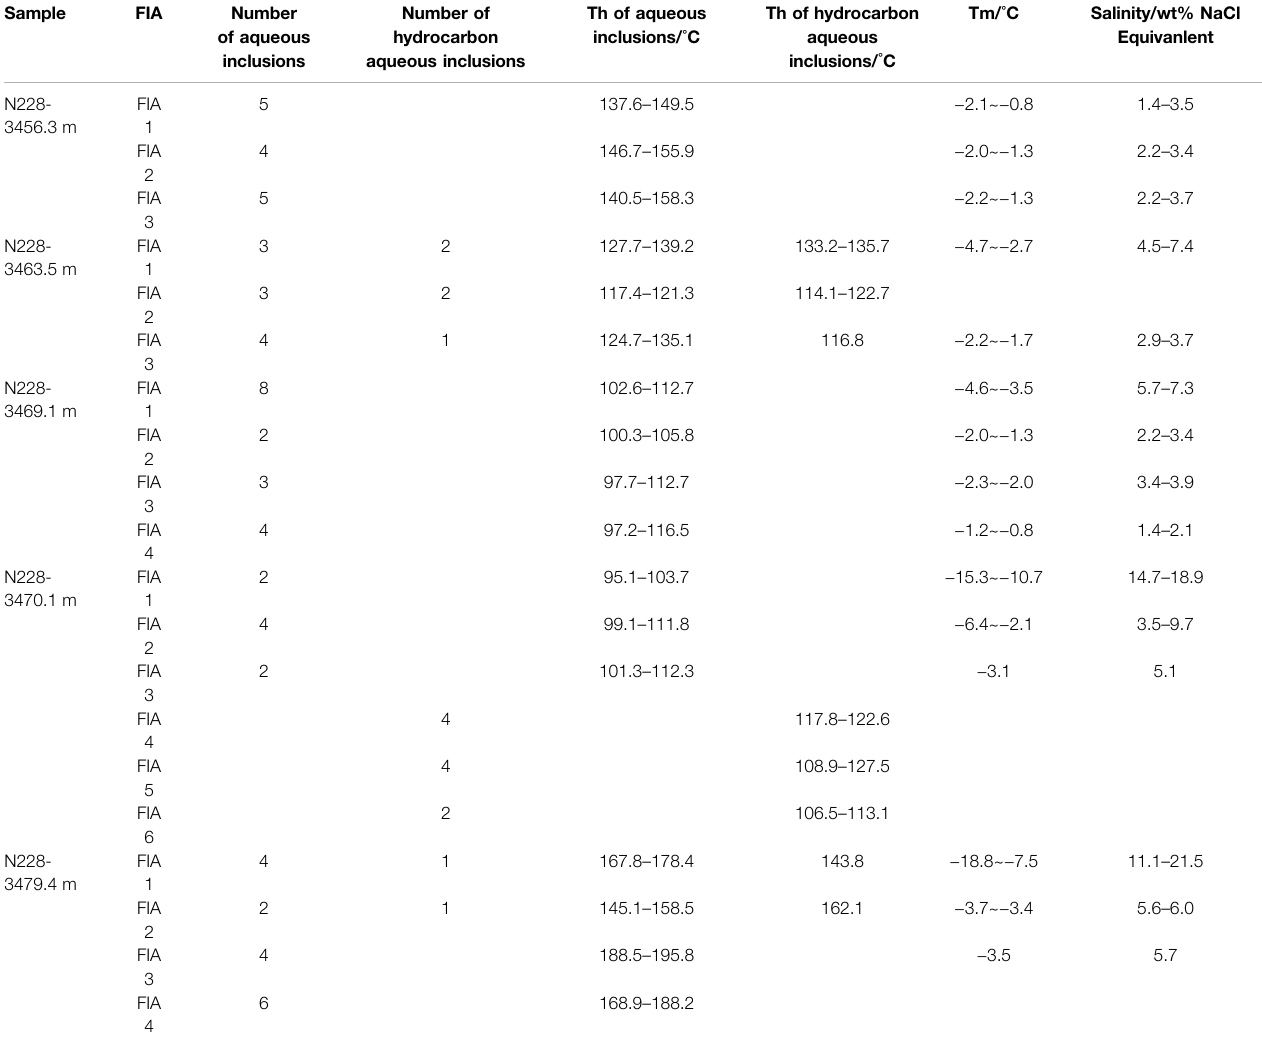
TABLE1| MeasuredTh,Tm,andcalculatedsalinityofaqueousandhydrocarbonaqueousinclusionssymbioticwithbituminousandmethaneinclusionsofallsamplesinwell N228 of the Changning area. Sample